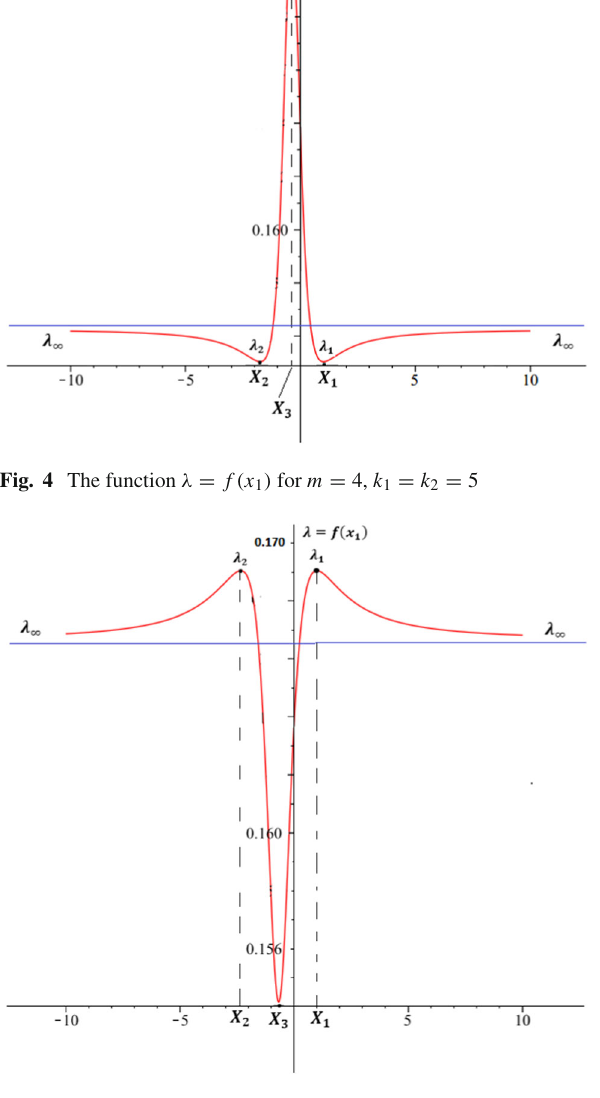
Fig. 5 The function λ = f ( x 1 ) for m = 5, k 1 = k 2 = 4